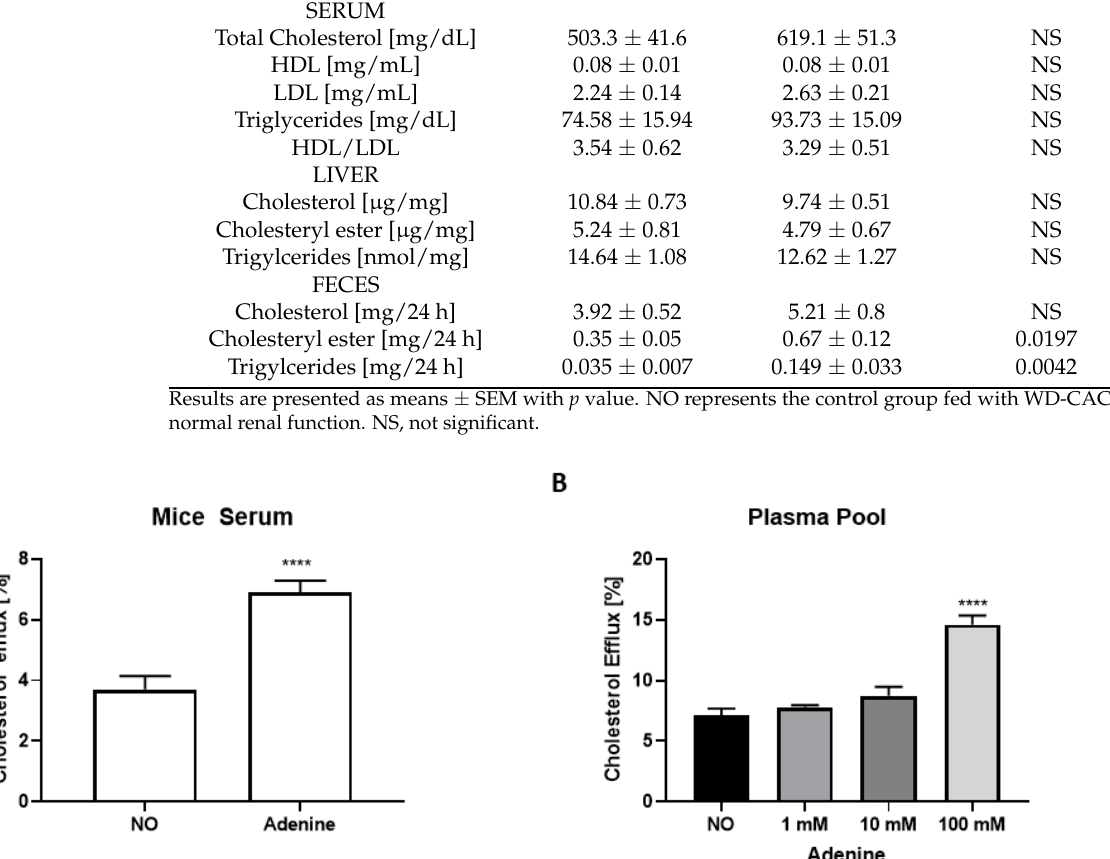
Table 2. Effect of adenine on lipid composition in serum, liver, and feces. Figure 3. Adenine-induced nephropathy leads to a reduction of atherosclerotic lesions. ApoE KO mice were fed for 2 weeks with WD-CAC, followed by 5 weeks with WD-CAC ± adenine and ath- erosclerotic lesions were quantified in the aortic valve. ( A ) Representative ORO staining of aortic root sections from control mice and ( B ) mice with adenine-induced nephropathy. ( C ) Quantification of aortic lesions in the aortic valve. NO represents the control group, fed with WD-CAC. Scale bar = 200 μ m. The data is plotted as a median with whiskers indicating the minimum and maximum values ( n = 7–8). For statistical significance, ** p < 0.01.